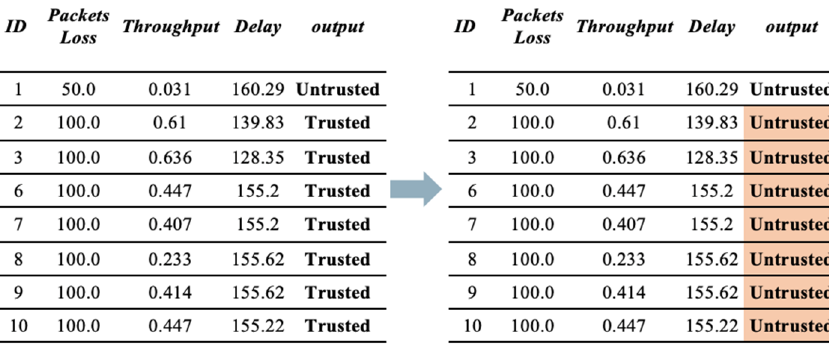
Figure 4. Sample of dataset before and after applying a bad-mouthing attack.